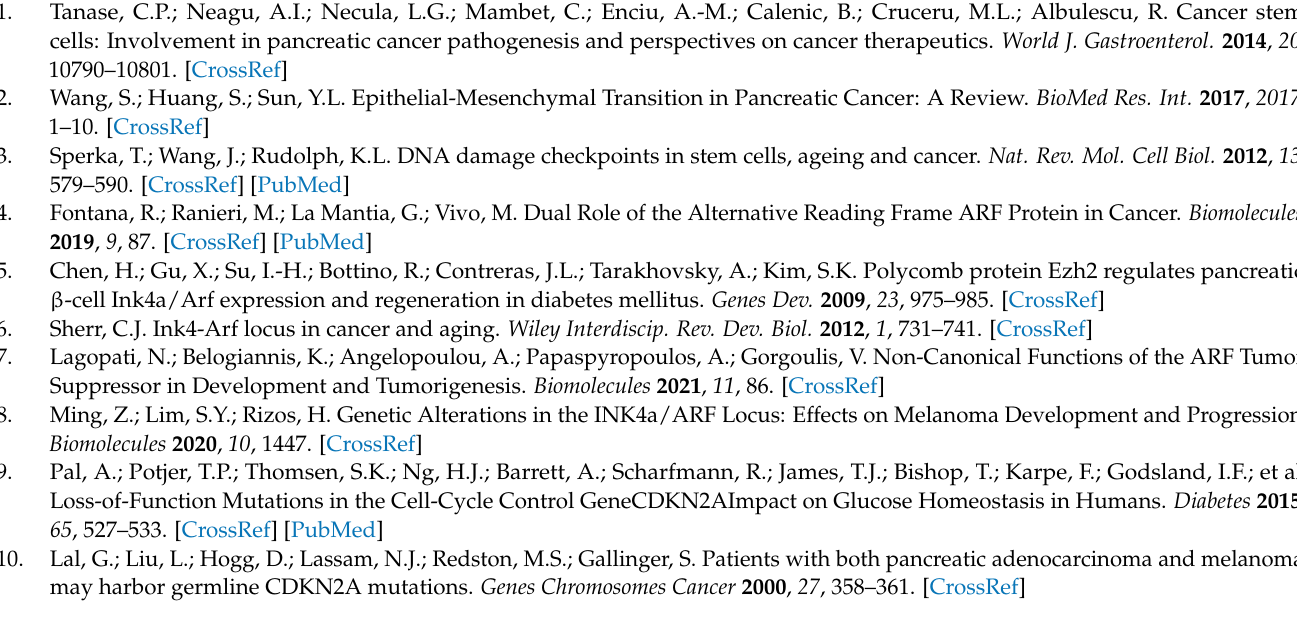
of Figure 2B, Figure S2: Immunofluorescence assays for Ink4 and Arf subcellular localization of Figure 2C, Figure S3: Full-length Western blots images of cropped immunoblots of Figure 2D, Figure S4: Full-length Western blots images of cropped immunoblots of Figure